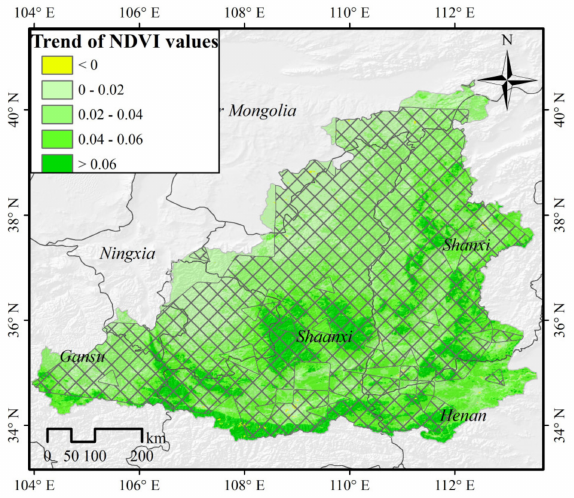
Figure 8. NDVI variation trend in the MRYRB from 2000 to 2018. The crosshatch indicates that the trend is statistically significant at the 95% confidence level based on t −